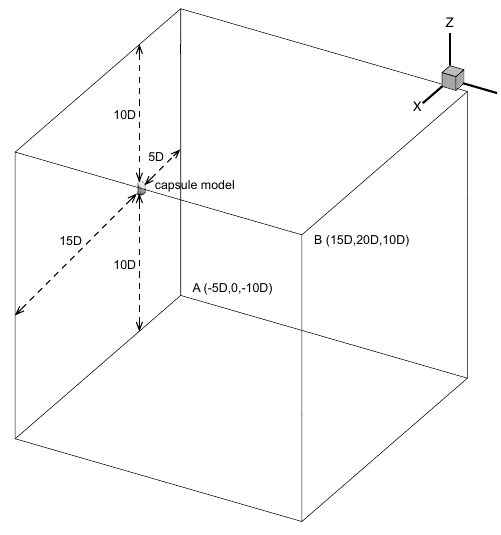
Figure 3. Computational domain.